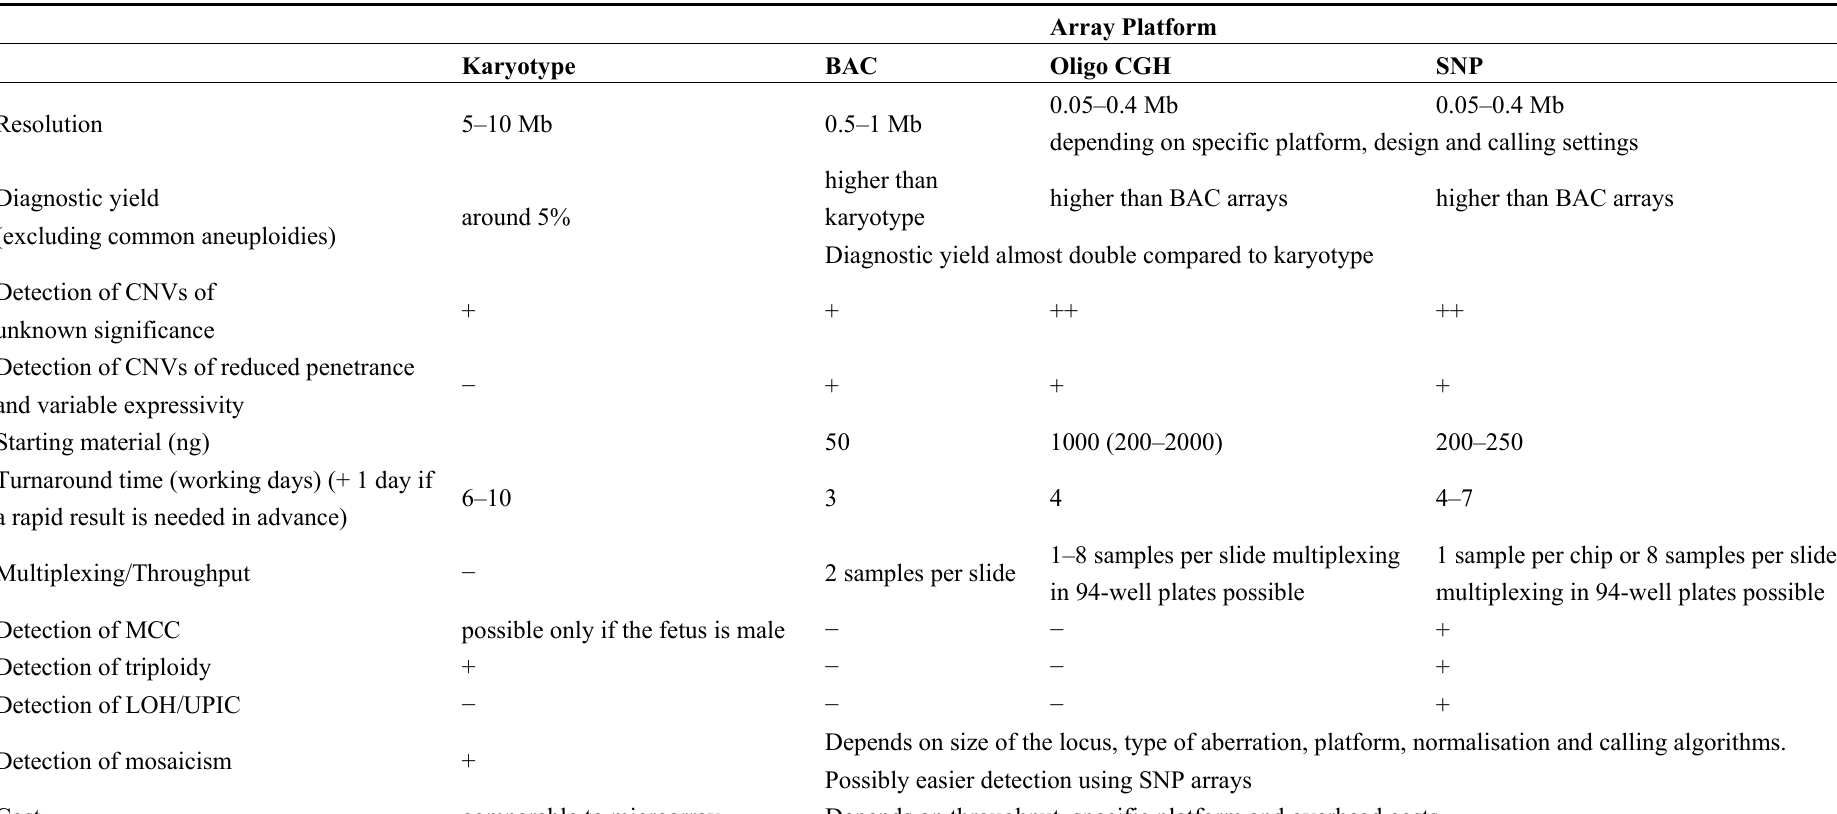
Table 1. Comparison between Karyotype, Bacterial Artificial Chromosome (BAC) arrays, oligo Comparative Genomic Hybridisation (CGH) and Single Nucleotide Polymorphism (SNP)